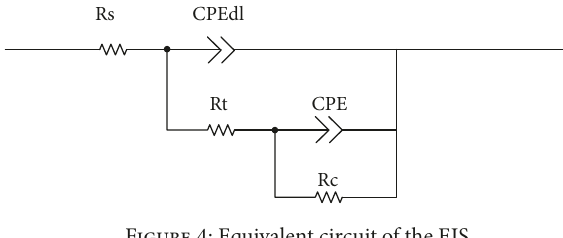
Figure 4: Equivalent circuit of the EIS.